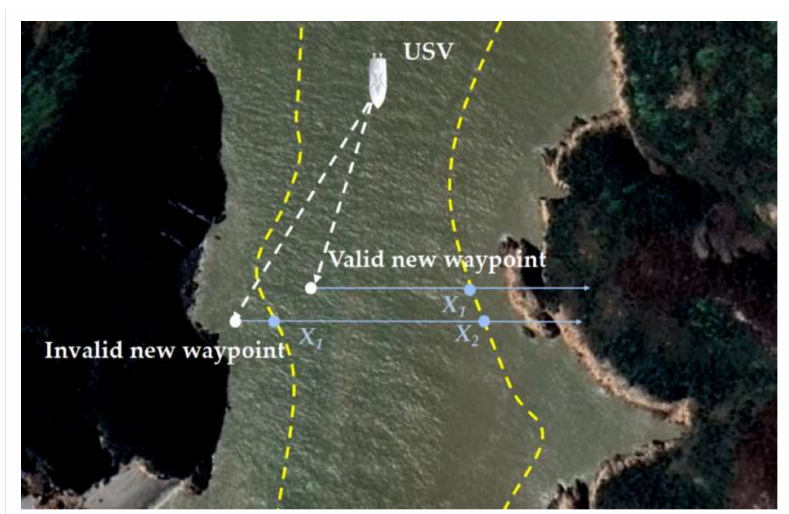
Figure 6. Implementation of terrain constraints using a ray casting